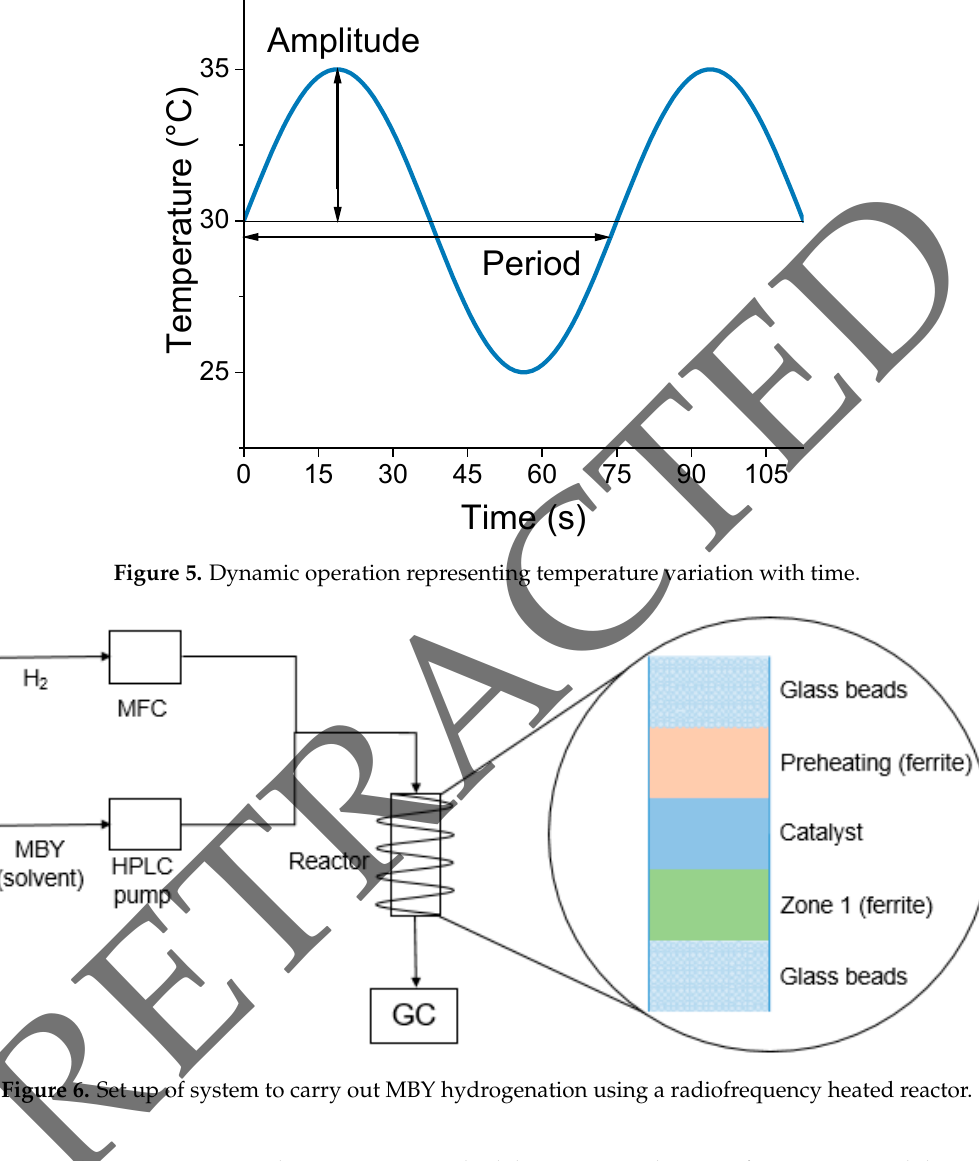
Figure 6. Set up of system to carry out MBY hydrogenation using a radiofrequency heated